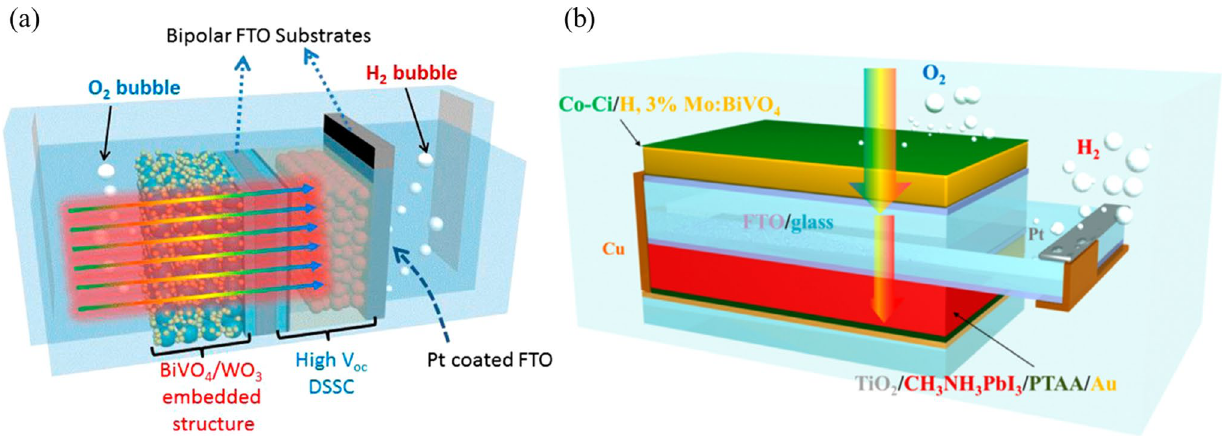
Fig. 3 Examples of PEC device structure classification ( adapted from Refs. [26] and [27]). Based on the classification scheme introduced in this study, device structures with SSJ-T are effectively considered as “wired” structures. Some of PEC device structures demonstrated by pre- vious works are effectively “wired” structures, although the structure is seemingly “wireless”, because there are a three SSJ-T (Reprinted with permission from Ref. [26]. Copyright (2015) Elsevier), and b two SSJ-T and one SSJ-O (Reprinted with permission from Ref. [27]. Copyright (2015) American Chemical Society) Fig. 4 STH efficiencies from previous studies [7, 8, 11, 21, 26–74] as function of the number of SSJ-T’s. The shape of the data points represents the inclusion of SSJ-T in a device structure (circle: not included, rectangle: included). The colors of outer, middle (for devices with three light absorbers) and inner circle or rectangle corresponds to top, middle (for devices three light absorbers) and bottom cell materials, respectively. Differ- ent colors represent different light absorbers (green: earth- abundant oxide, blue: crystal- line Si, light blue: amorphous Si, red: halide perovskite, purple: any materials contain- ing In, As or Ge, yellow: others, which are mostly chalco- genides and organics). The size of datapoint represents lifetime-H in log 2